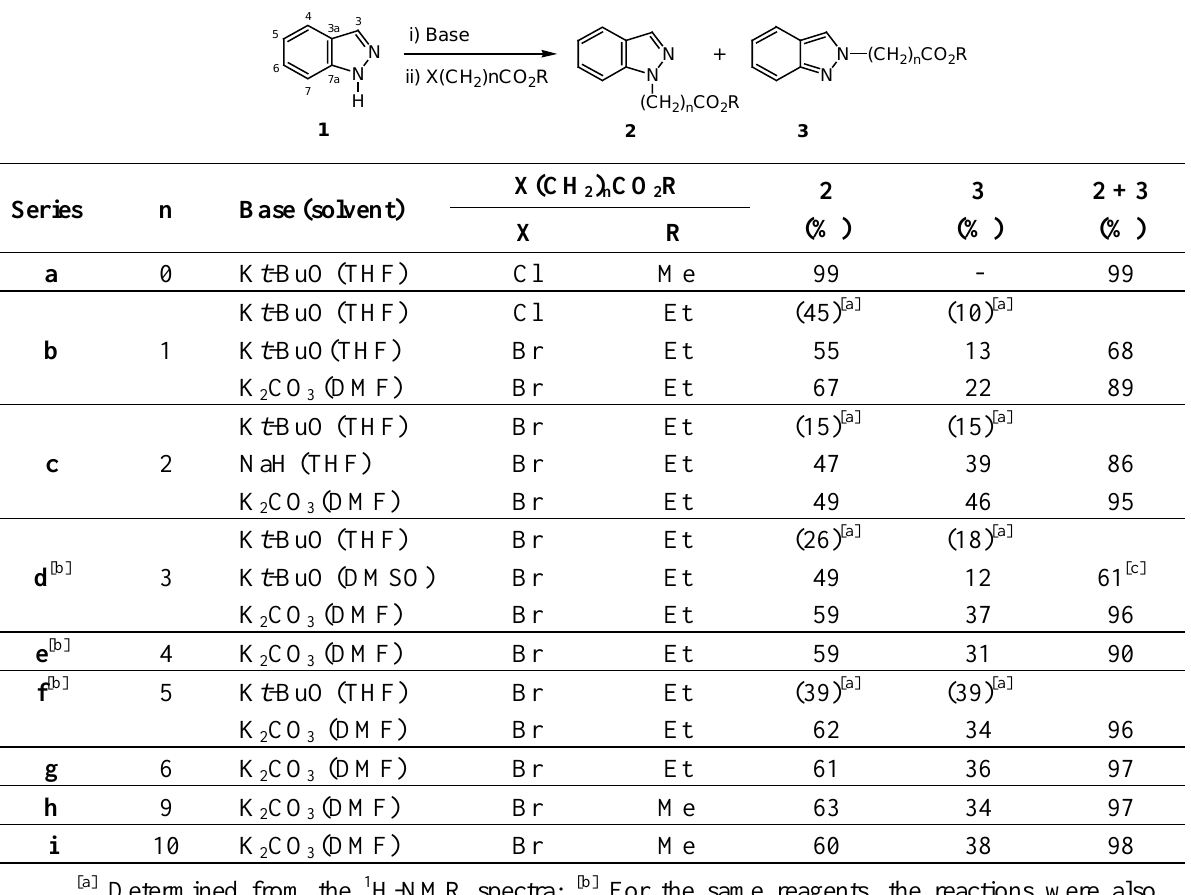
Table 1. Synthesis of indazole derivatives substituted at N-1 and N-2 ( 2 and 3